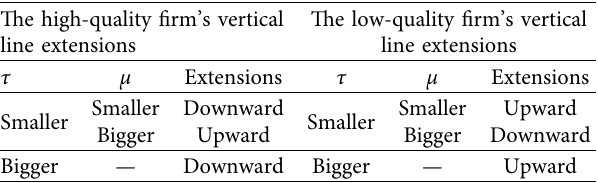
Table 2: Summary of research conclusions. The high-quality firm’s